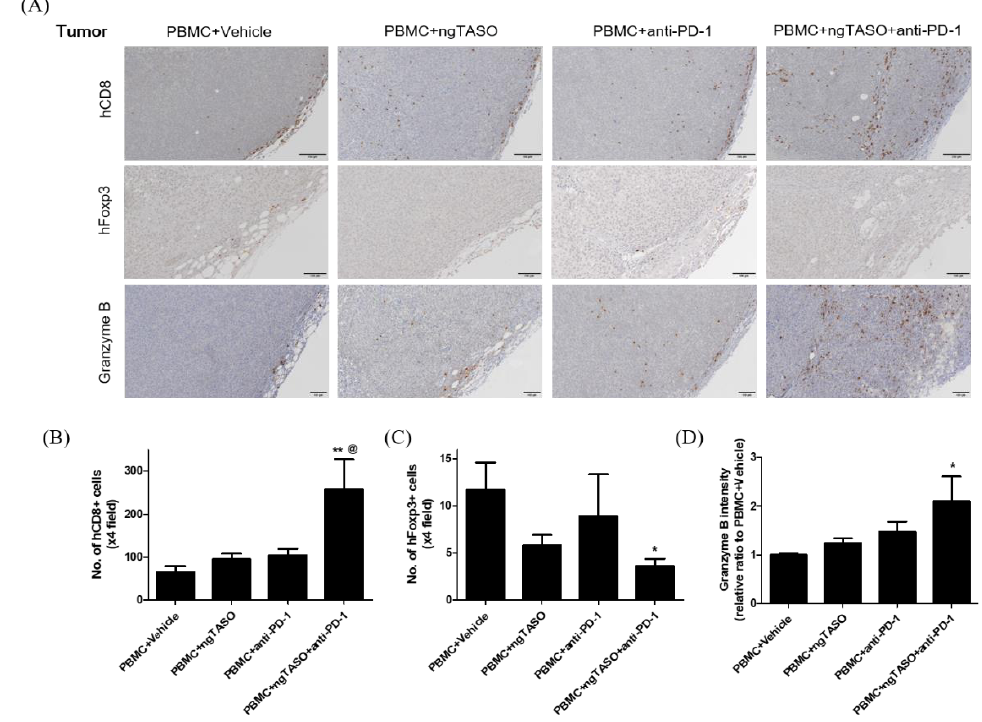
Figure 6. Effects of TGF- β 2 blockades combined with PD-1 inhibition on the distribution of tumor infiltrated T cells and their activation. Infiltration and distribution, and activation of human T cells in the tumor were measured by IHC staining against hCD8, hFoxp3, and granzyme B. ( A ) Representative IHC images of hCD8, hFoxp3, and granzyme B expression. The number of ( B ) hCD8+ cells and ( C ) hFoxp3+ cells per ×4 field, and ( D ) the relative DAB intensity ratio of granzyme B were assessed in at least four fields per specimen and five to six specimens per group. The results are expressed as mean±S.E.M. * p < 0.05 and ** p < 0.01 vs. PBMC+Vehicle group; @ p < 0.05 vs. PBMC+ngTASO group (Dunnet’s test). Bar = 100 µ m. h,